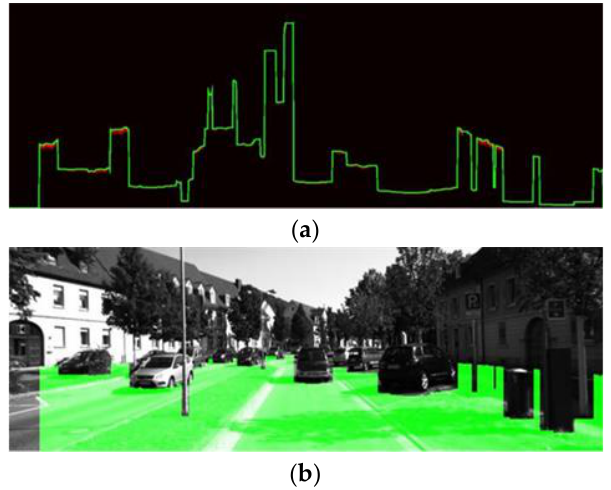
Figure 6. Result of extracted free space: ( a ) dividing line of free space and obstacle; and ( b ) result of free space on ground.